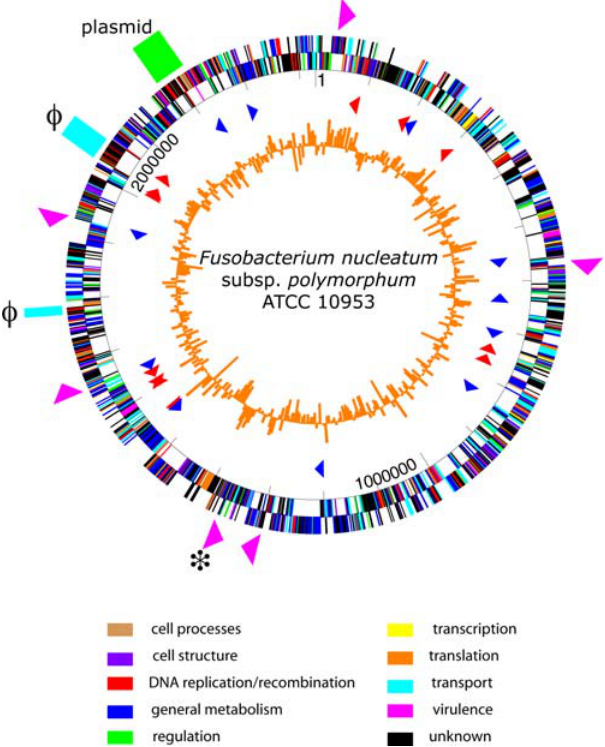
Figure 1. Map of the FNP ATCC 10953 genome. The inner circle (orange) shows the percent GC calculated using a sliding window of 5 kb. The triangles in the next circle show the location and directionality of tRNAs (red) and ncRNAs (blue). The next tract shows the coordinate scale; this is surrounded by the ORFs, on both strands. ORFs are colored by category, as follows: tan, cell processes; purple, cell structure; red; DNA replication and recombination; blue, general metabolism; green, regulation; yellow, transcription; orange, translation, cyan, transport; fuchsia, virulence; and black, unknown. The IStrons are indicated by the fuchsia arrowheads on the outside circle; the intact IStron is indicated with the star. Plasmid (green) and phage locations (cyan) also appear on the outside